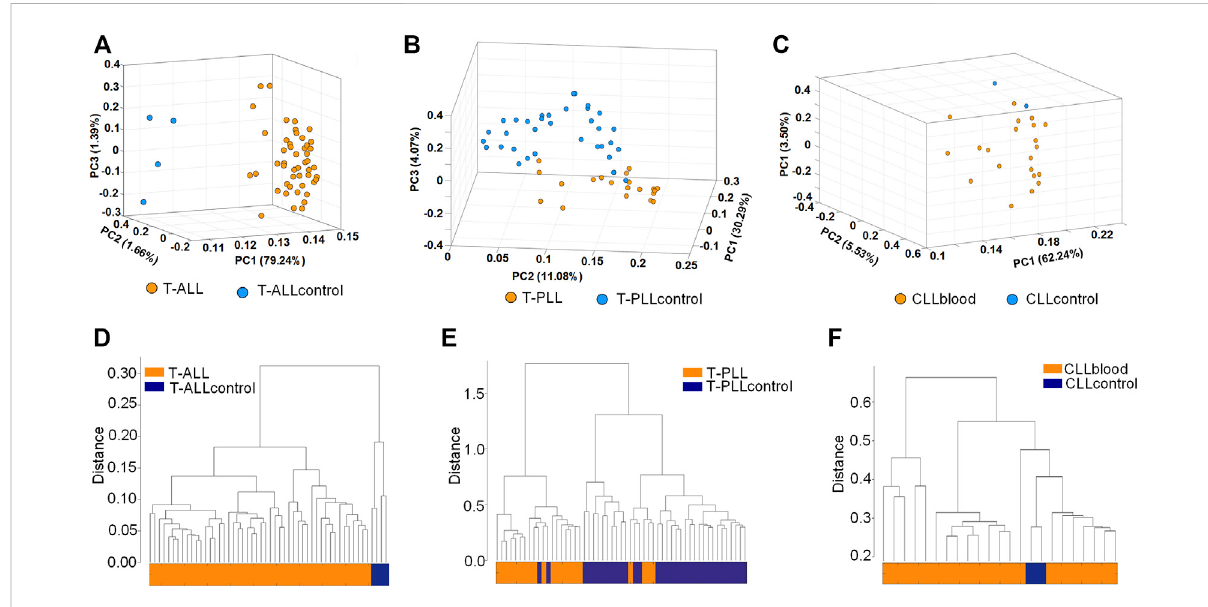
FIGURE 2 Principal component analysis and hierarchical clustering analysis (A – C) The principal component analysis of T-ALL, T-PLL and CLLblood samples, respectively. The editing levels of M/E sites were used (D – F) The hierarchical clustering of T-ALL, T-PLL and CLLblood samples, respectively. The expression levels of original miRNAs, edited miRNAs and the editing levels of the M/E sites after normalization were